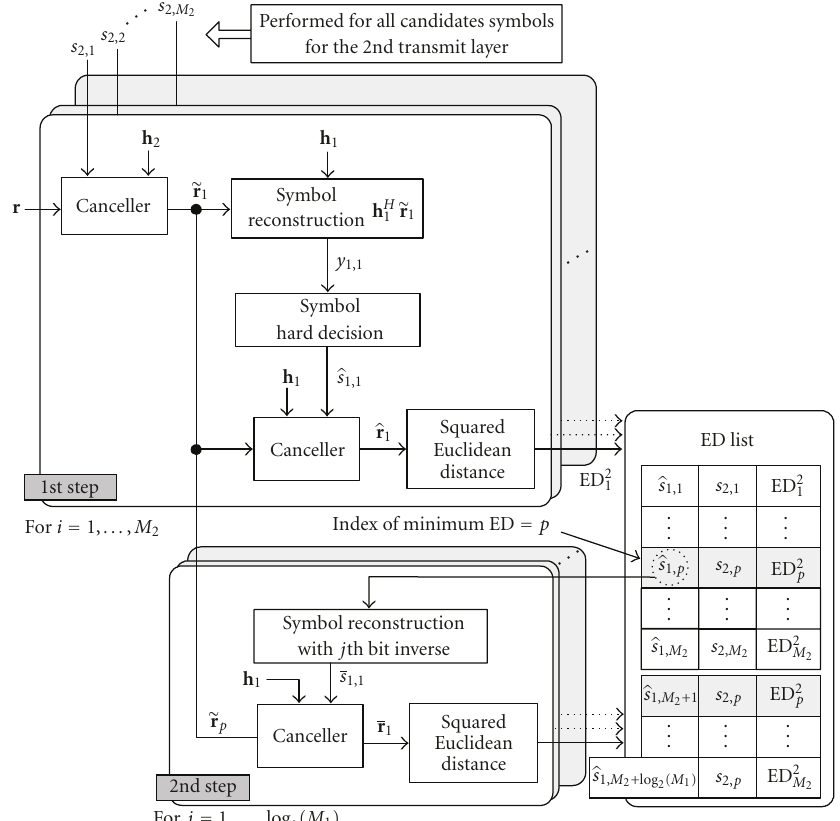
Figure 4: Block diagram of the proposed decoding scheme I.